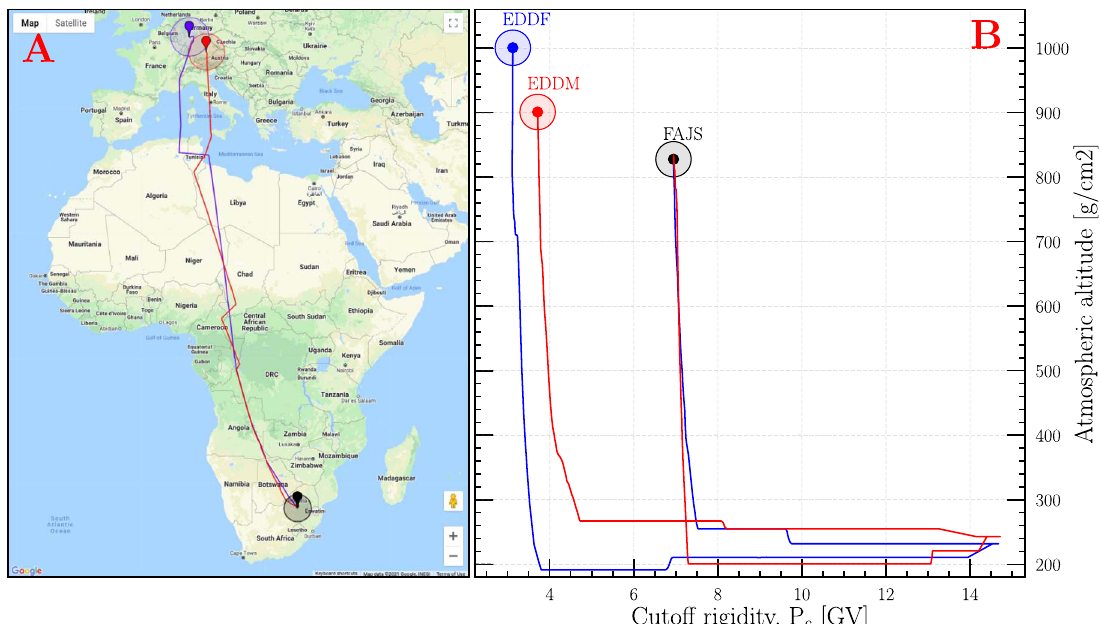
Figure 1. Panel A shows the test fl ight routes from FAJS to EDDF (in blue) while the return fl ight to FAJS from EDDM is shown in red. Panel B shows the fl ight altitudes (in terms of atmospheric depth) as a function of the corresponding vertical geomagnetic cutoff rigidity, P c. Panel